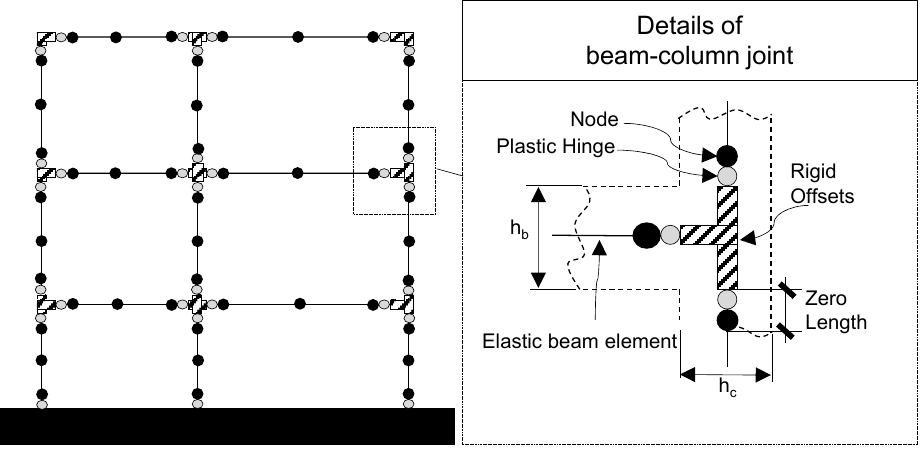
Figure 8. Modeling features.